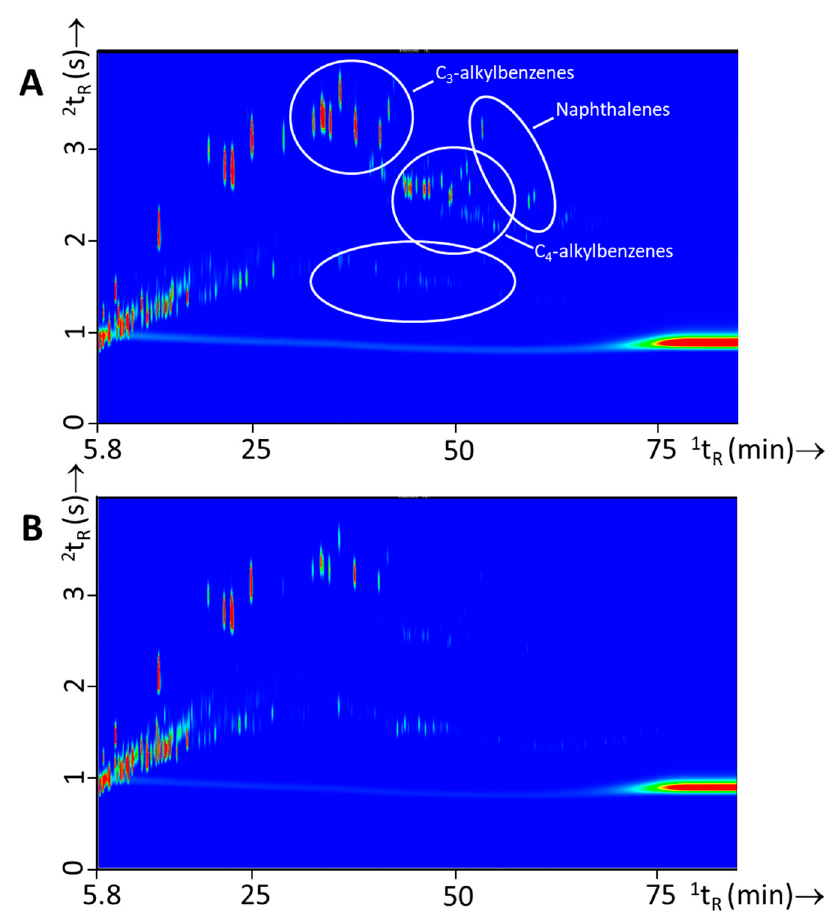
Figure 6. GC × GC-TOFMS TIC contour plots of two different batches of gasoline with ( A ) experiment 127 (Shell) and ( B ) experiment 129 (BP). Differences in the samples are highlighted with white circles.